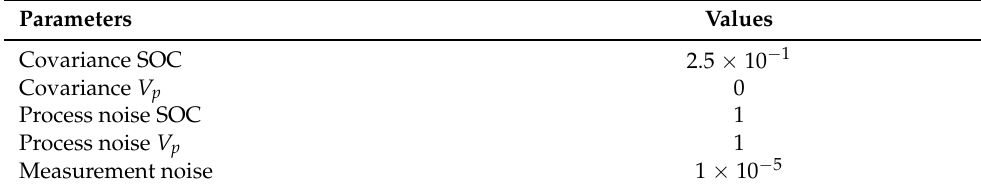
Table 1. EKF tuning parameters.